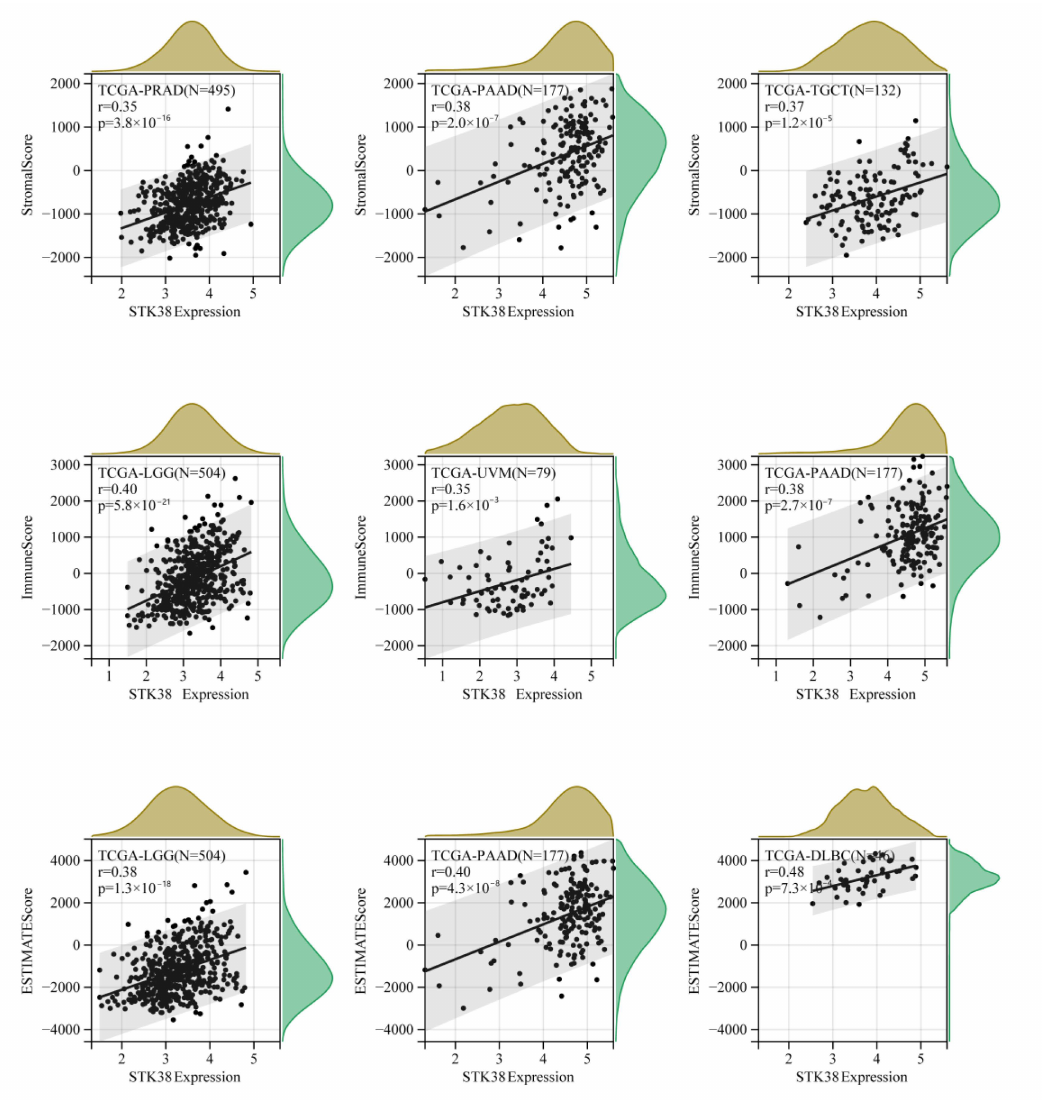
Figure 6. Top three scatter plots of correlation between STK38 expression and ImmuneScore, Stroma- lScore and ESTIMATEScore in multiple